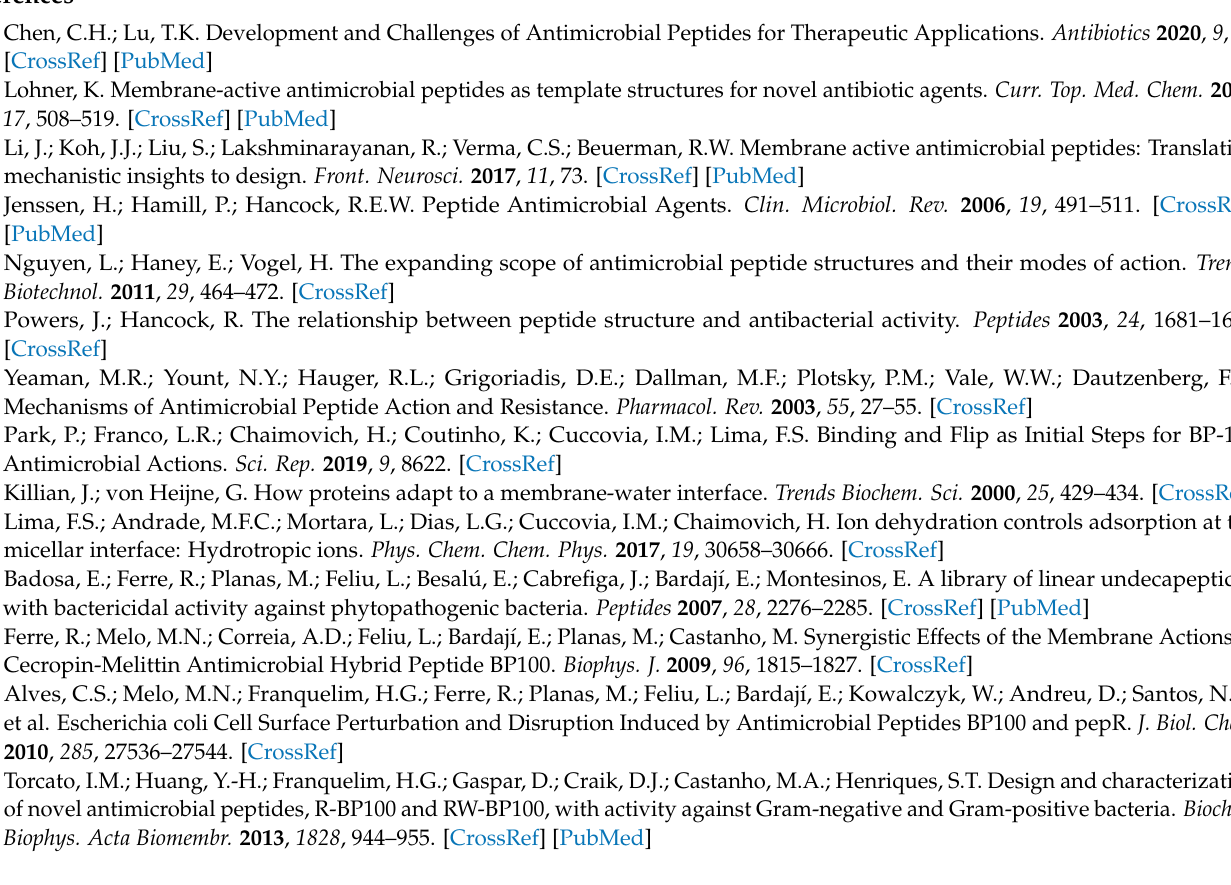
(B) Average lipid/peptide ratio in which 50% of NAPHT-BP100 is bound to LUV of varied lipid composition at 25, 45, and 65 ◦ C, Figure S6: (A) Fluorescence and (C) CD spectra of NAPHT-BP100 20 µ M in solution and in presence of POPC LUV, in 10 mM Tris-HCl buffer, pH 7.4. (B) Binding isotherm obtained from the spectra presented in (A) and (D) [ θ ] at 222 nm as function of lipid concentration obtained from data in